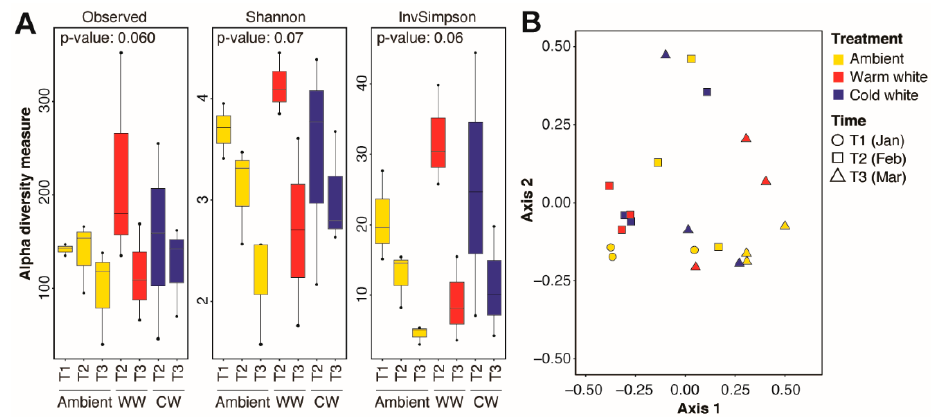
Figure 2. Alpha and beta diversity of the Acropora digitifera microbiome. ( A ) Observed amplicon sequence variants (ASVs), Shannon, and inverse Simpson indices for coral samples subjected to various light treatments (ambient moonlight, Ambient; warm white, WW; and cold white, CW) for different durations. Kruskal-Wallis test p -values for comparisons are shown. ( B ) Principal coordinates analysis of microbial communities in corals exposed nightly to ambient moonlight, warm white light, or cold white light for different durations.